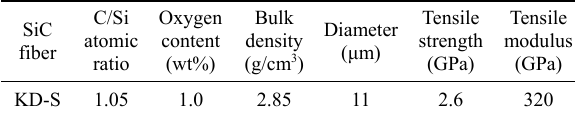
Table 1 Properties of KD-S SiC fiber